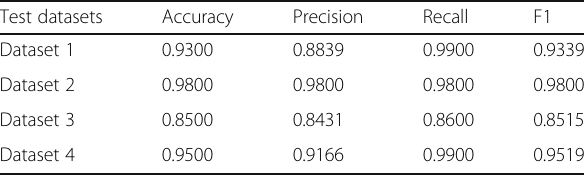
Table 3 Test results for telecommunication fraud detection rules Test